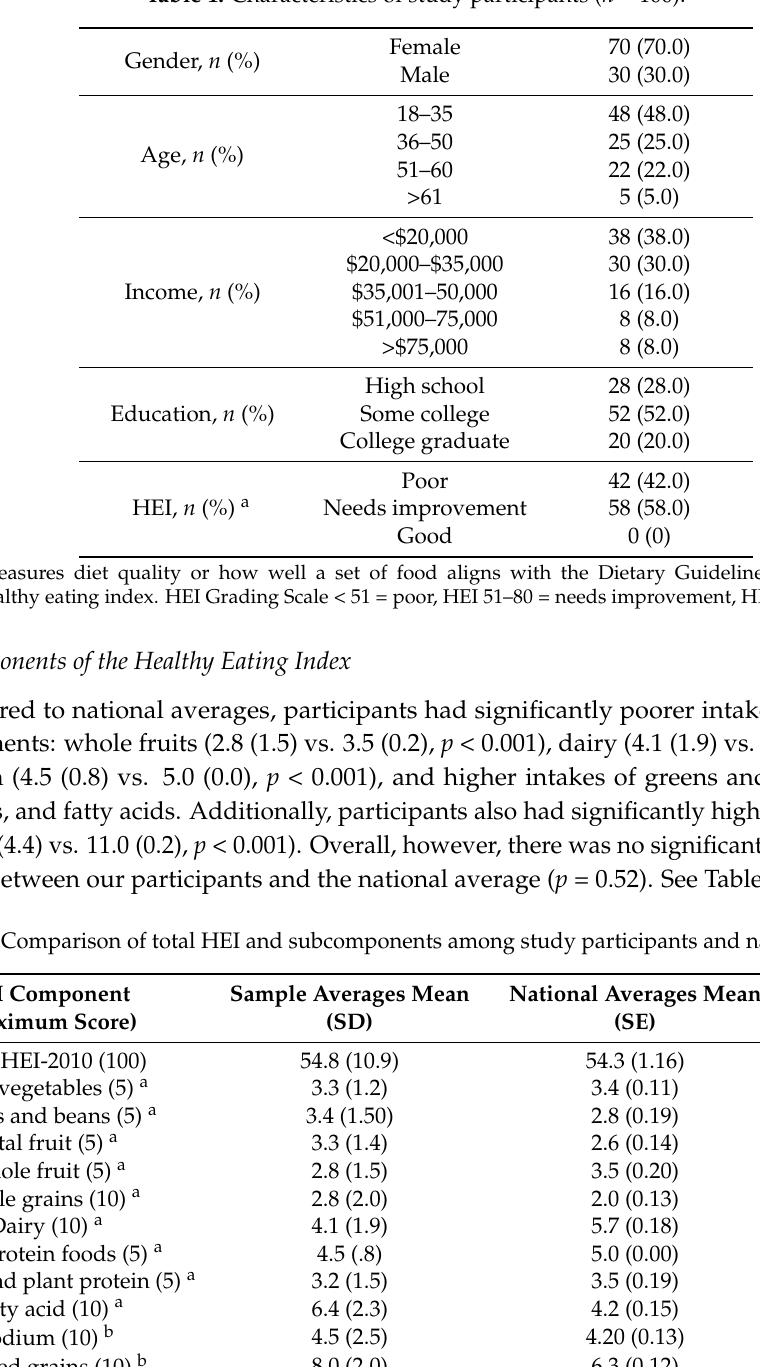
Table 1. Characteristics of study participants ( n = 100).